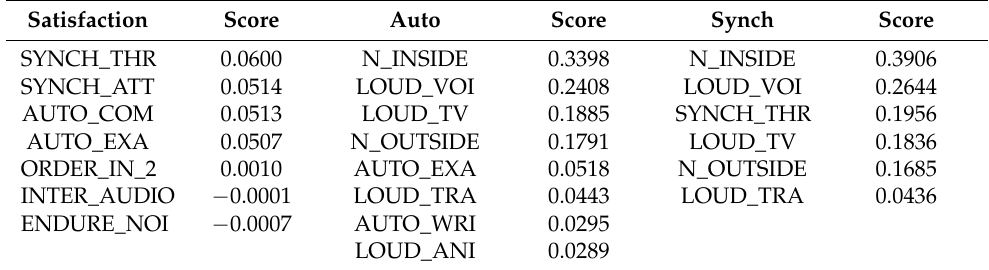
Table 1. Selected features with the mRMR method for the models of students’ satisfaction with online learning (Satisfaction; SAT_ONLINE) and the models for the interference of noise with autonomous (Auto; INT_AUTO) and synchronous (Synch; INT_SYNCH) academic activities. The score of each variable is also shown. The meanings of the acronyms of the selected variables are shown in Table A1.